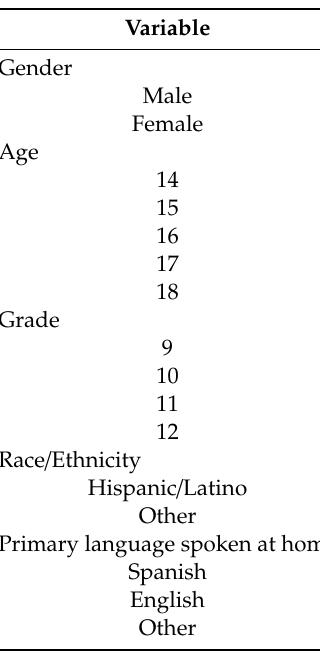
Table 1. Demographic statistics of the study sample ( N =